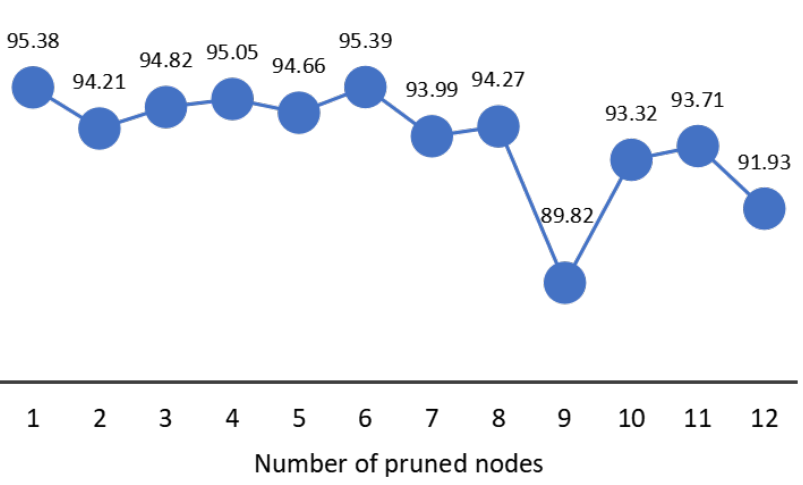
Figure 6. Prediction accuracy of BP network through pruning different nodes. The horizontal ordinate represents the layers of pruned MRRs, and the ordinate represents the prediction